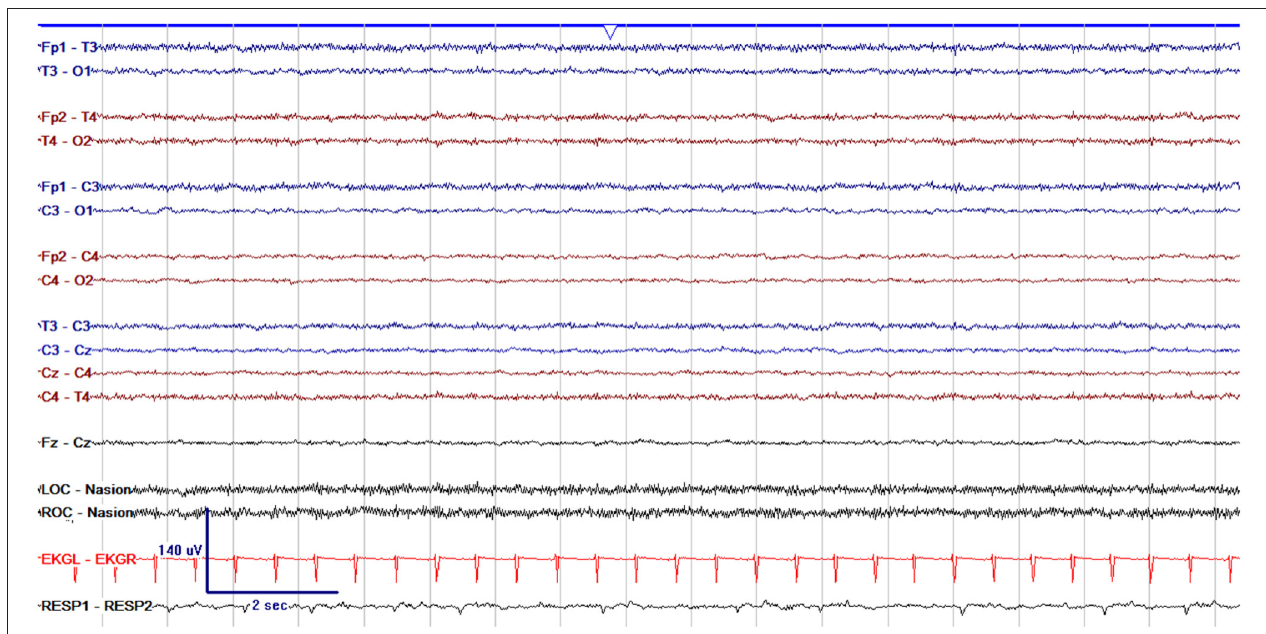
FIGURE 5 | Severely abnormal cEEG background which is entirely suppressed with voltage < 10 µ V and featureless in a 1 day old former 37 + 6 week GA (37 + 7 week PMA) neonate.